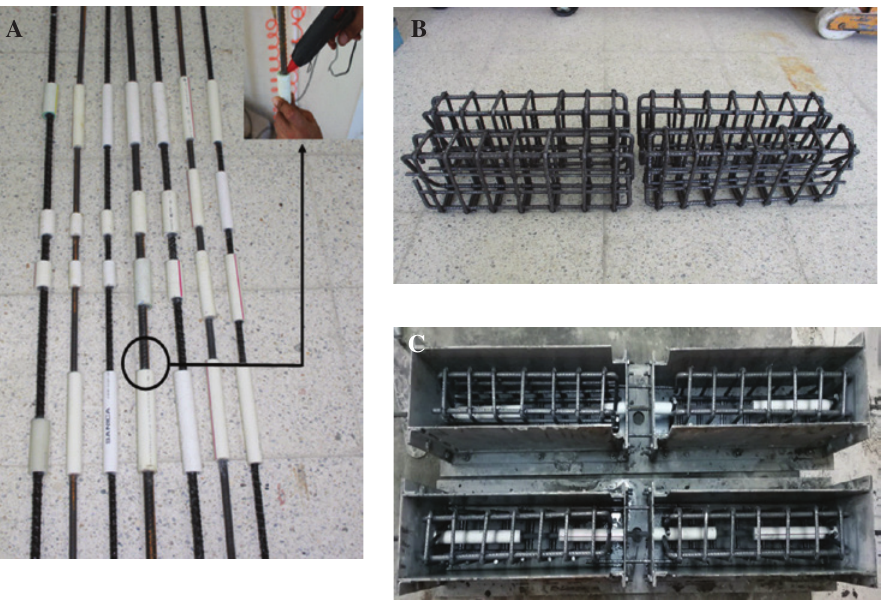
Figure 6: Preparation phases of the hinged beam samples: (A) limiting process of the embedment length, (B) prepared stirrup reinforce- ment, and (C) beam samples ready for the concrete casting.